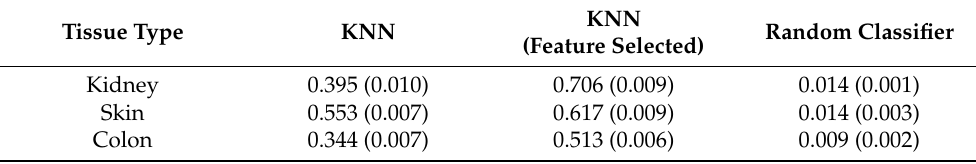
Table 7. Cross-validation classification accuracy in predicting laboratory of origin of ROI tiles; standard deviation in